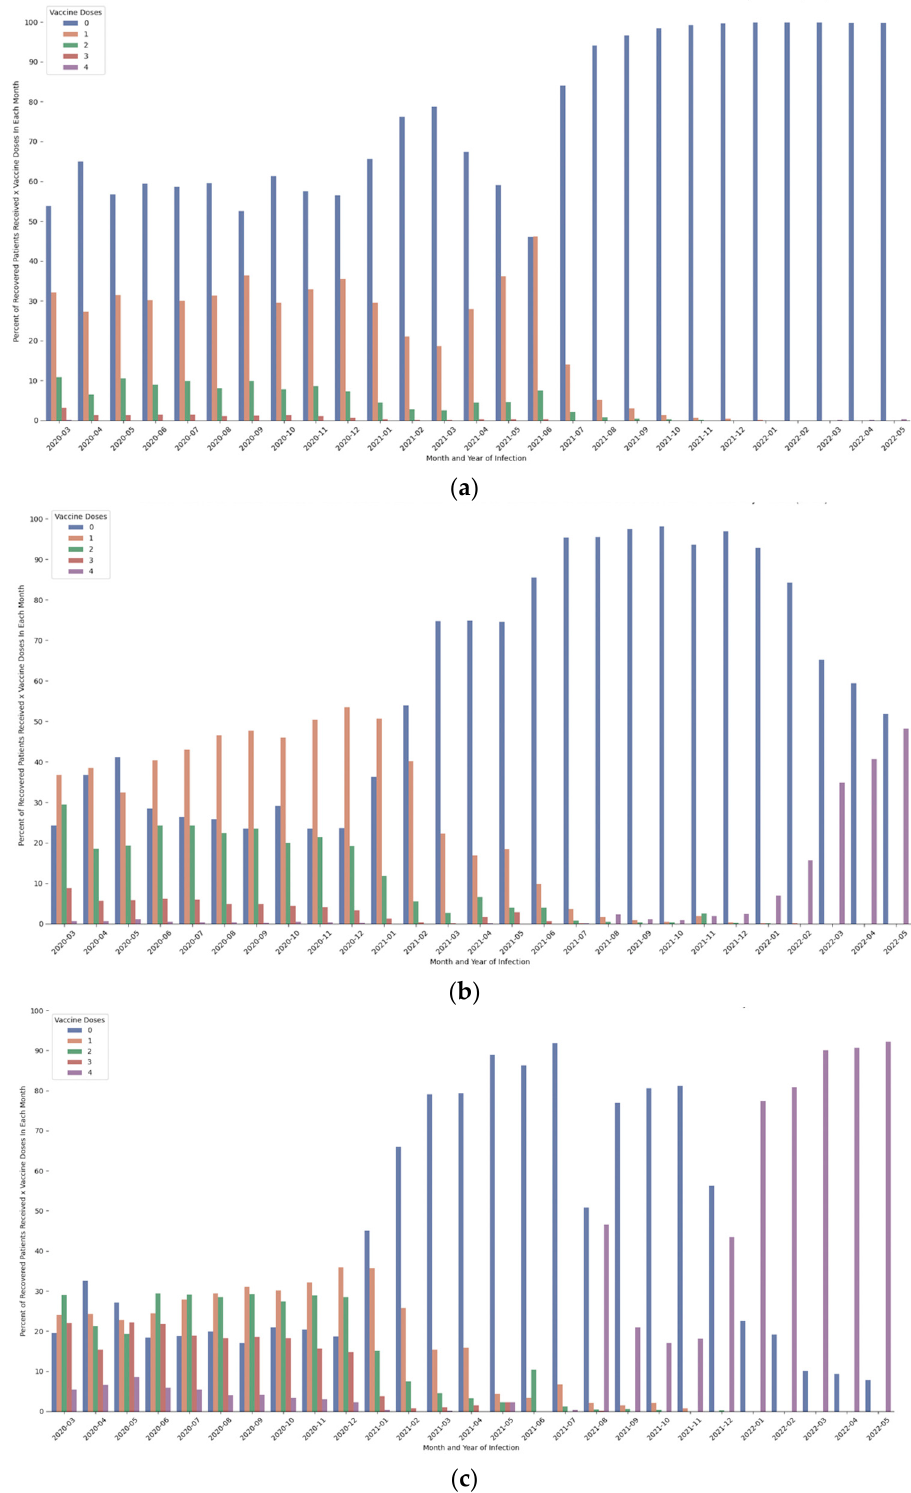
Figure 3. Per-month infection (year-month), percentage of recovered patients by age (( a ): 0–19 years; ( b ): 20–59 years; ( c ): 60 years and above) according to number of vaccine doses received. Note: data only include recovered patients who received no vaccine doses prior to infection.